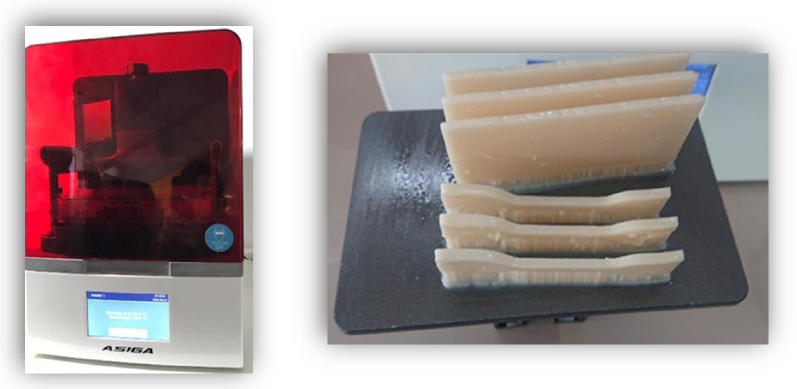
Figure 6. 3D Printing samples.